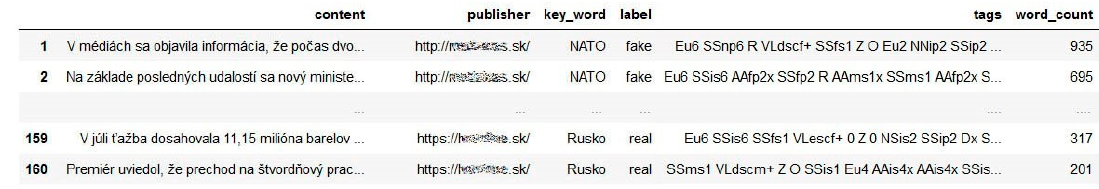
Figure 2. Preview of the dataset created after identifying morphological tags and calculating the number of words in each article (publisher of the articles is anonymized).